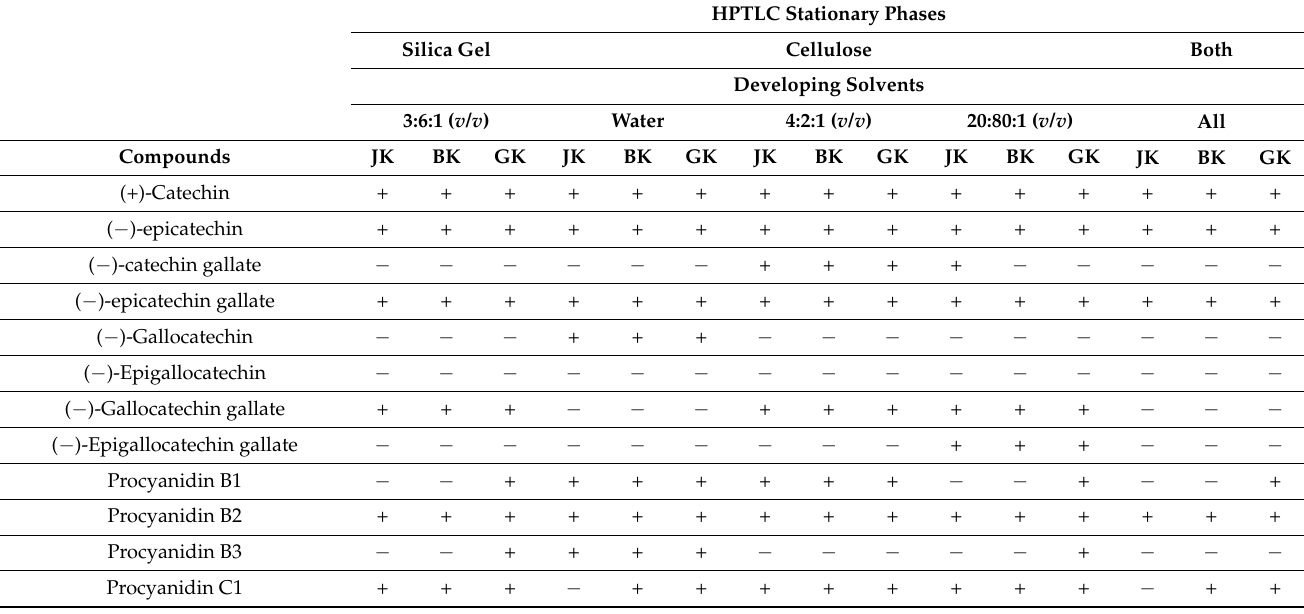
Table 1. Confirmation of the presence of flavan-3-ols and proanthocyanidins based on matches of the R F values of standards and blue bands in tracks of STSs from rhizomes of Japanese (JK), Bohemian (BK) and giant (GK) knotweed on all HPTLC silica gel and cellulose plates. The HPTLC silica gel plate was developed with toluene–acetone–formic acid (3:6:1, v/v ) [9], while the HPTLC cellulose plates were developed using the following developing solvents: water [17,19,20] and 1-propanol– water–acetic acid in different ratios (4:2:1, v/v [17,20]; 20:80:1, v/v [20–22]). The final confirmation of the compounds was only awarded to those which were detected using both stationary phases (column “Both”) and all developing